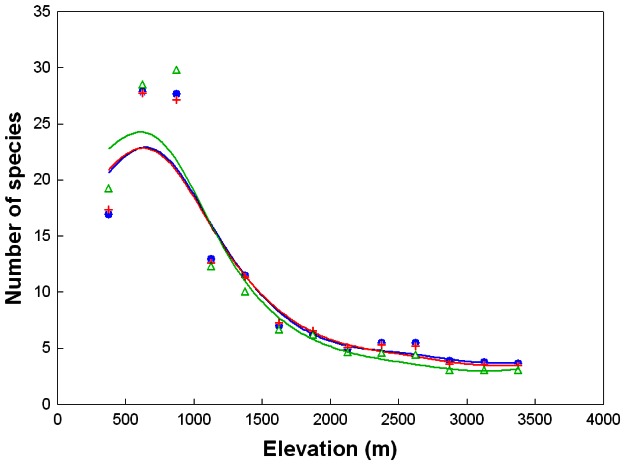
Area-controlled relationships between phanaeine species richness and elevation for elevationally variable z-values based on empirical phanaeine z-values adjusted for the corresponding elevational variation in empirical z-values for birds reported by Rahbek
[3]
. Blue dots/line: all South American countries except Chile (grouping A), z = 0.382. Red crosses/line: all South American countries except Chile and Brazil (grouping B), z = 0.367. Green triangles/line: only the tropical Andes countries Bolivia, Colombia, Ecuador and Peru (grouping C), z = 0.299. Curves are based on the interpolated number of species and area of each elevational zone in Bolivia, setting area to 50 000 km2. See Materials and Methods for details. Curves were fitted by distance-weighted least squares smoothing.